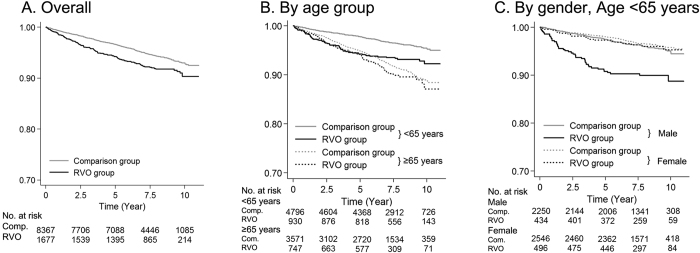
Acute myocardial infarction (AMI)–free survival rate for the retinal vein occlusion (RVO) group and the comparison group (Comp.) over the 11-year follow-up period.The overall AMI-free rate (A) AMI-free rate by age group (<65 years and ≥65 years) (B) and AMI-free rate by gender in subjects aged <65 years (C) are shown.